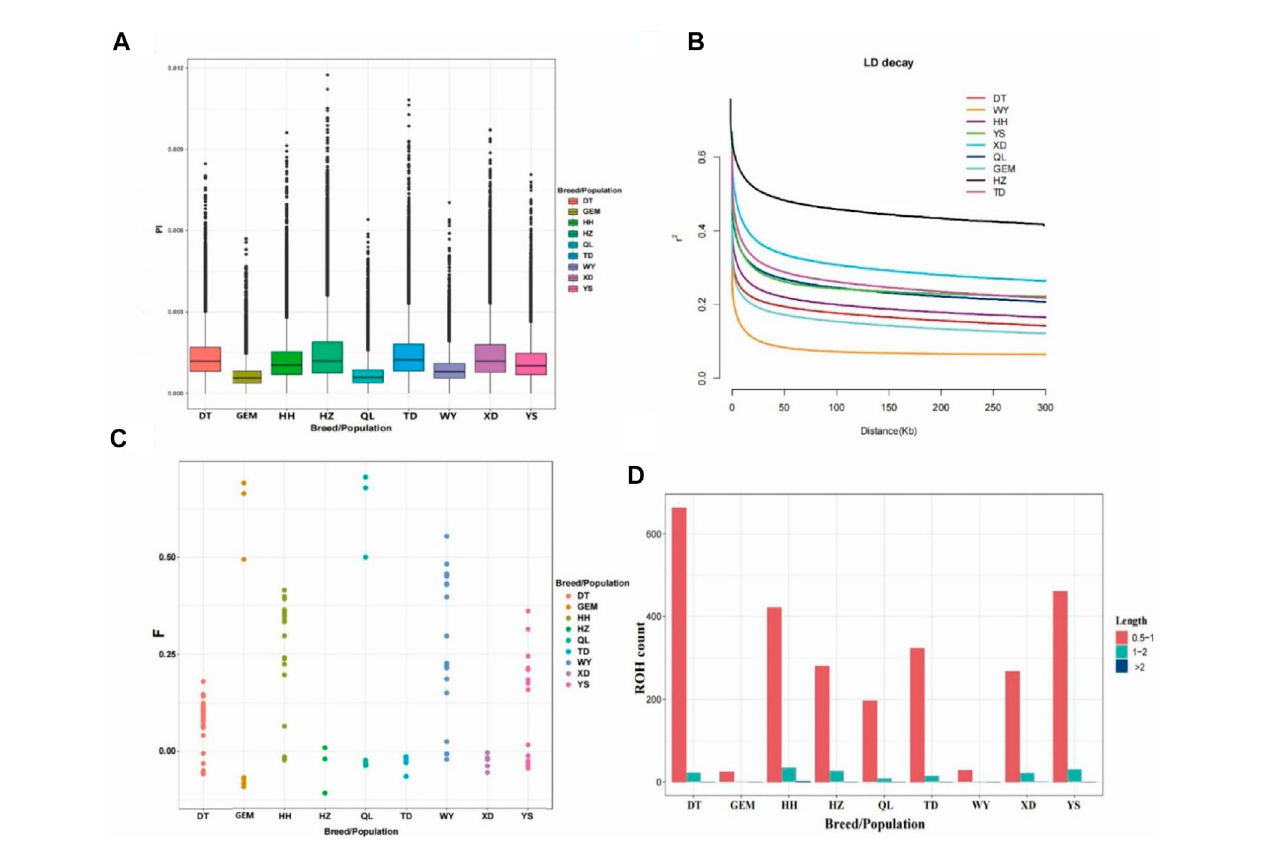
FIGURE 2 Analyses of genomic variation, LD, F Hom , and ROHs for Qinghai yak breeds/populations. (A) Box plots of nucleotide diversity (Pi) for each yak breed/ population. (B) Decay of LD in nine yak breeds/populations, with one line per breed/population. (C) F Hom in nine yak breeds/populations. (D) Length and average number of ROHs in nine yak breeds/populations.